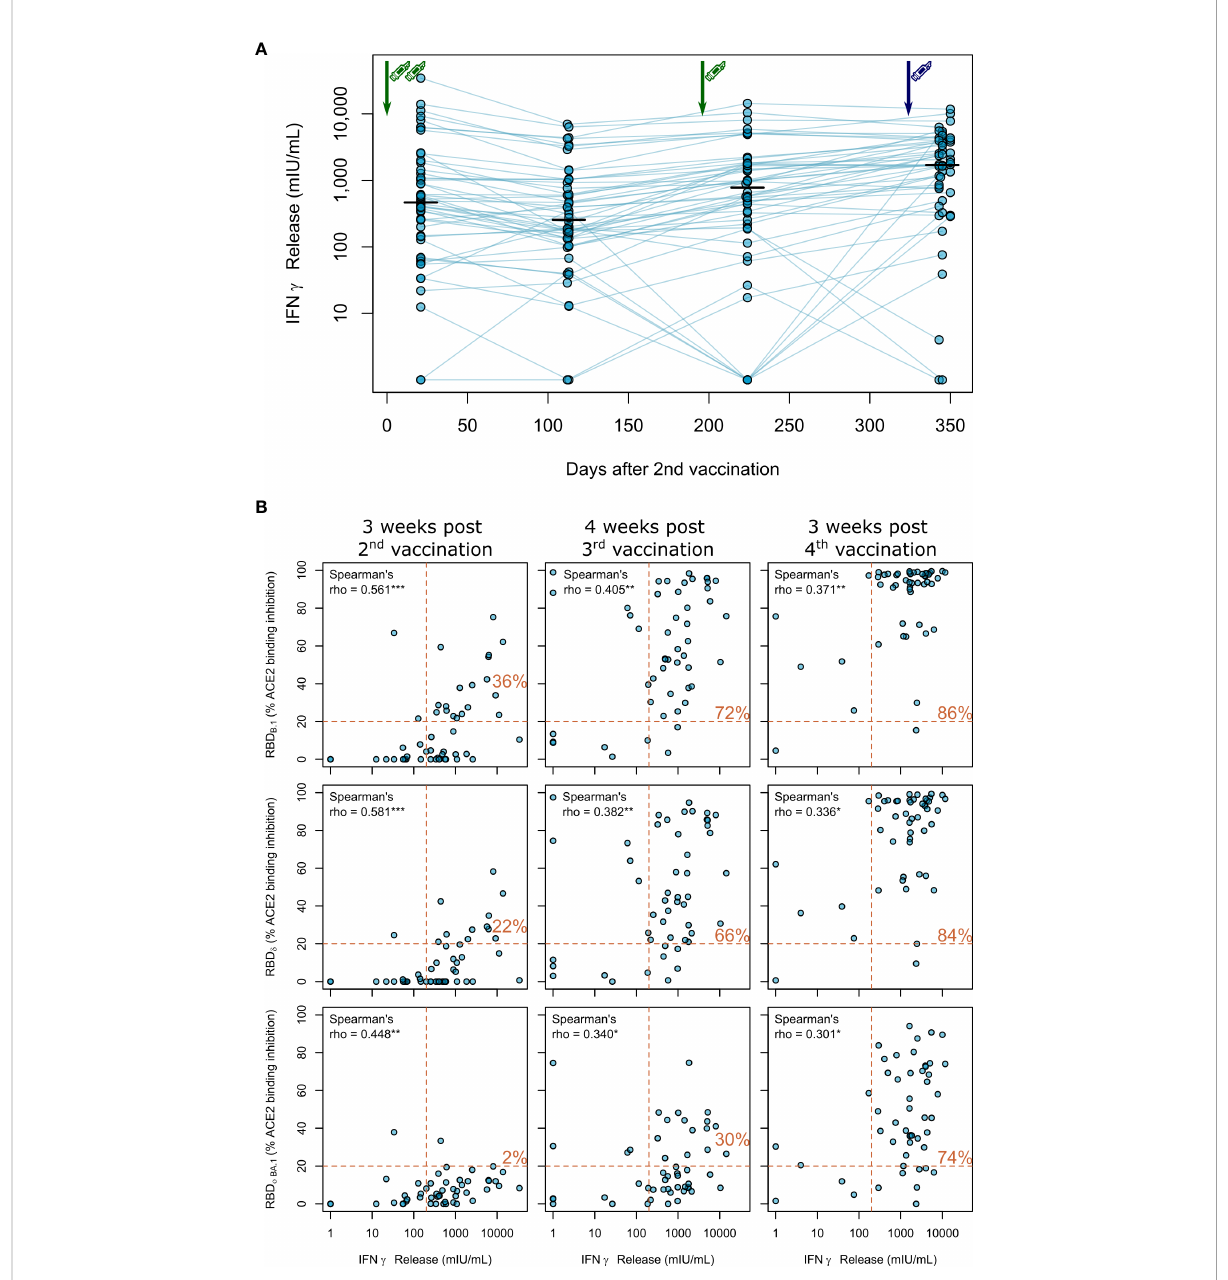
FIGURE 4 Impact of triple vaccination with BNT162b2 and a fourth full-dose of mRNA-1273 on cellular immune response in haemodialysis patients. (A) Whole blood from longitudinally-sampled vaccinated haemodialysis patients (n = 50) was ex vivo stimulated using a SARS-CoV-2 Spike S1- speci fi c peptide pool. Supernatant fractions were then analysed by interferon g release assay (IGRA). Interconnecting lines represent samples from the same individual. Sampling time points in days after two-dose BNT162b2 vaccination is displayed on the x-axis. Statistical signi fi cance was calculated by two-sided paired Wilcoxon rank test. Signi fi cance was de fi ned as p<0.05. All p-values for relevant comparisons are listed in Table S3. Response data from dialysed individuals from day 21 after the second BNT162b2 dose were already published before as part of Strengert et al. (16) and Dulovic et al. (17). (B) T-cell responses assessed by IGRA and B-cell responses assessed by ACE2-RBD competition assay towards the RBD of B.1, Delta, Omicron BA.1 isolates were plotted for correlation analysis (B) . Correlation was calculated using Spearman ’ s coef fi cient rho. P values are marked as * <0.05, ** <0.01, *** <0.001. Dashed lines indicated the respective responder thresholds for IGRA (IFN g release >200 mIU/mL) and RBD-ACE2 binding assay (20%). Responder rates (%) for both cellular and humoral response are shown in the upper right